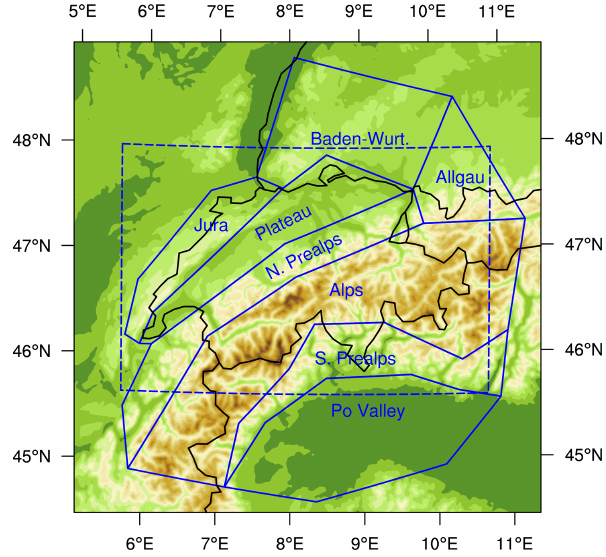
Figure 3. Sub-domains used in this study (solid blue lines). Terrain elevation and national borders are shown as in Fig. 1. “N. Prealps” stands for northern Prealps, “S. Prealps” stands for southern Pre- alps, and “Baden-Wurt.” stands for Baden-Württemberg. The study domain is shown by the dashed blue line. Plot produced using NCL version